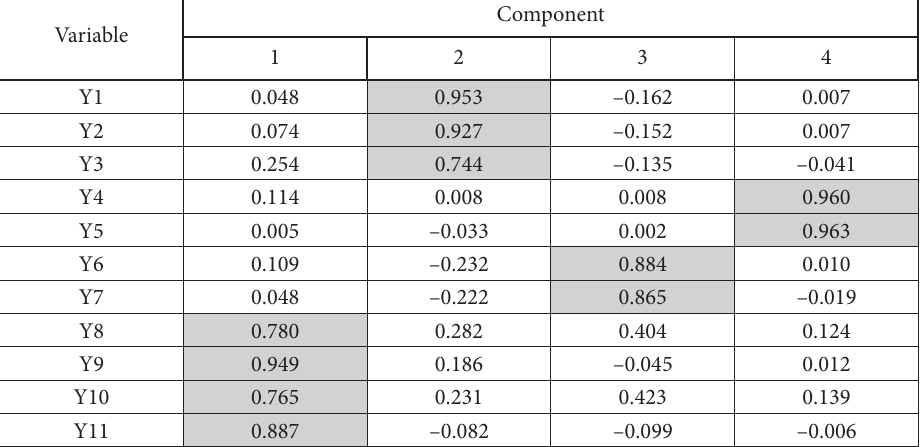
Table 4. Component